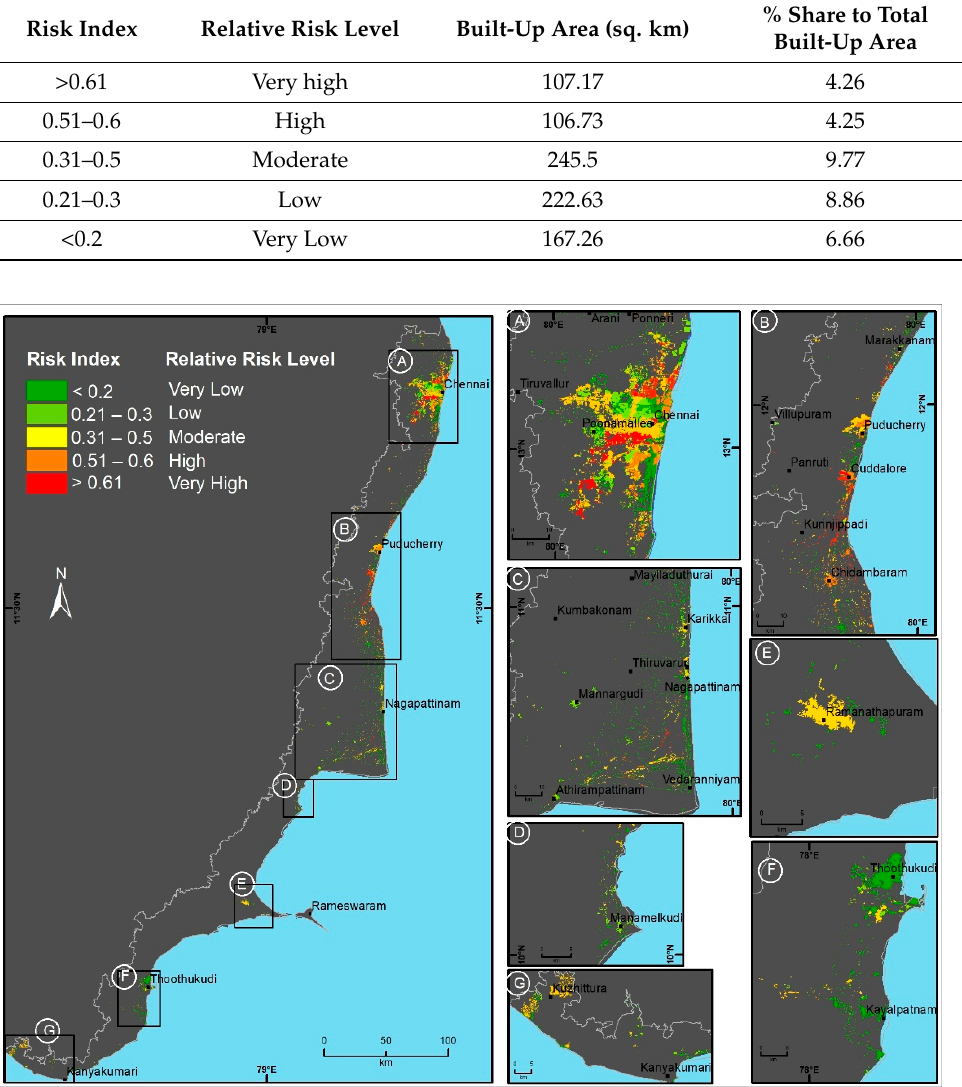
Figure 10. Spatial distribution of built-up area flood risk assessment. The inset figures depict A) Chennai region, ( B ) Cuddalore region ( C ) Nagapattinam region ( D ) Manamelkudi region ( E ) Ra- manathapuram region ( F ) Thoothukudi region ( G ) Kanyakumari